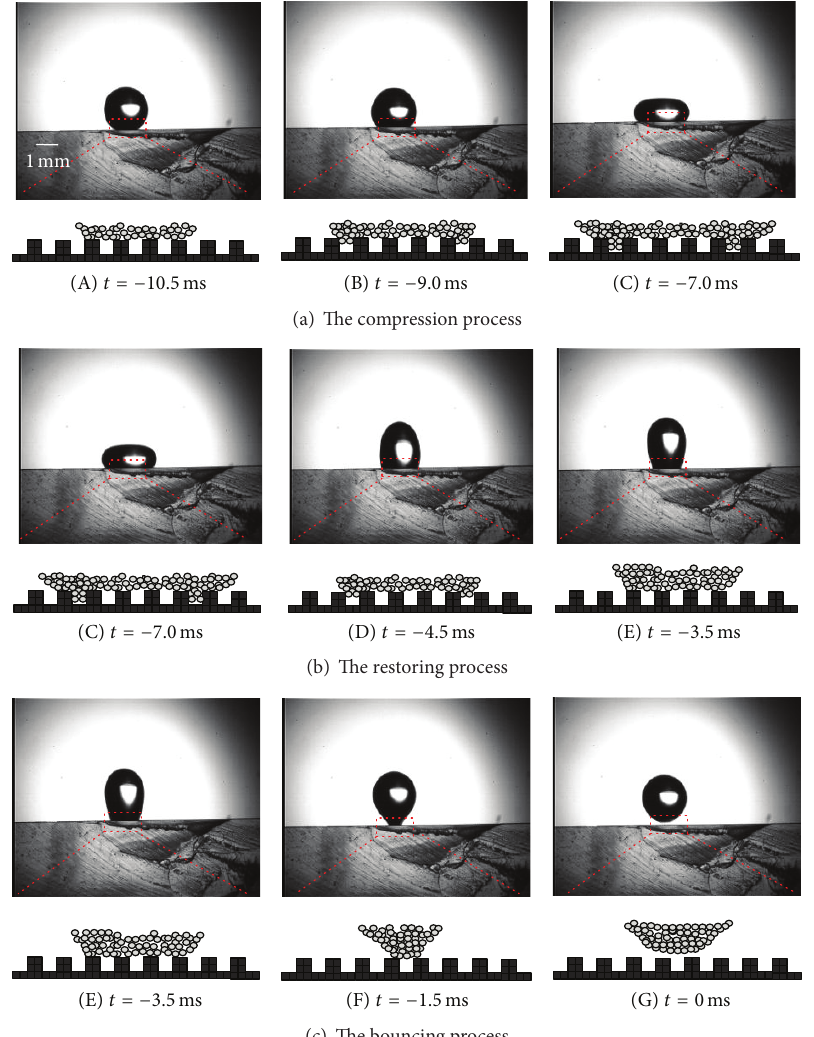
Figure 7: Scheme illustrating the droplet wetting